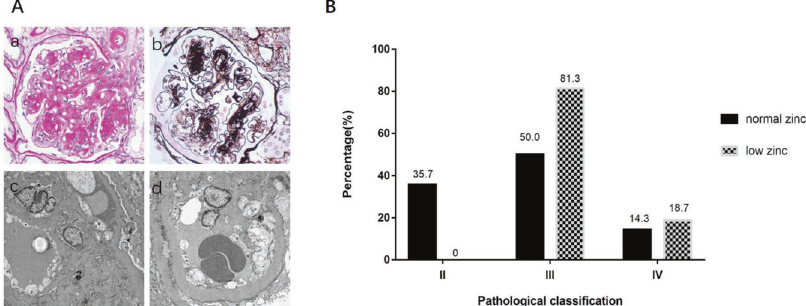
Fig. 6 Pathological classi fi cations of patients with DN. A Typical pathological change of DN (PAS staining*400, Masson staining *400, EM*6000). B In general, the pathological classi fi cation of the low-zinc group was more serious than that of the normal-zinc